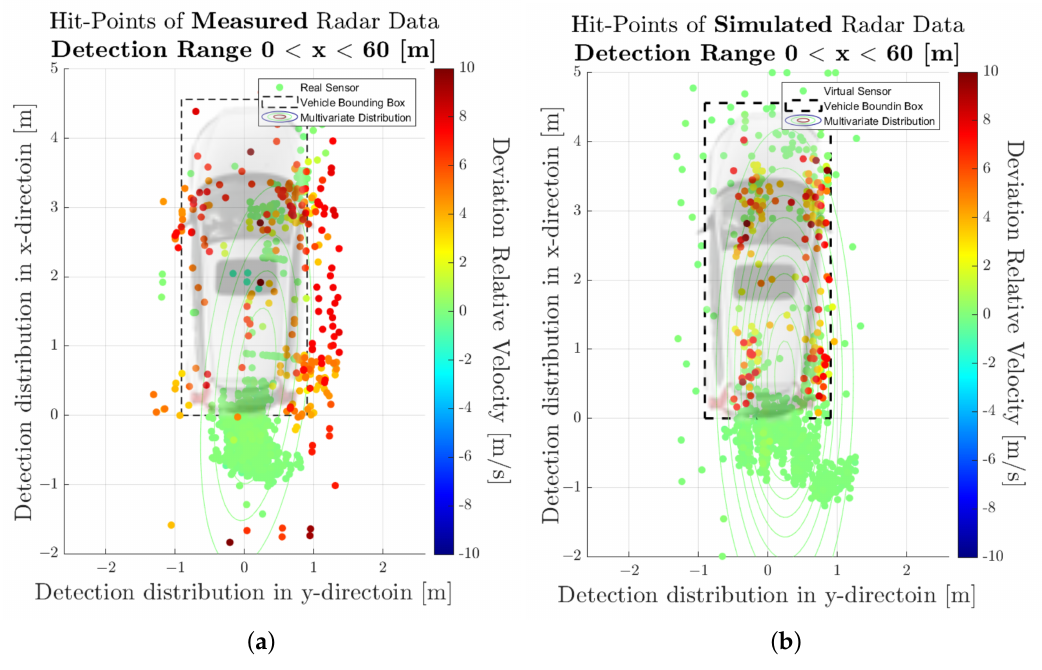
Figure 7. Visualisation of the measured and simulated radar point cloud data, accumulated over the entire measurement time, in the near-range detection sector. ( a ) Scatterplot of detections for the real sensor. ( b ) Scatterplot of detections for the sensor